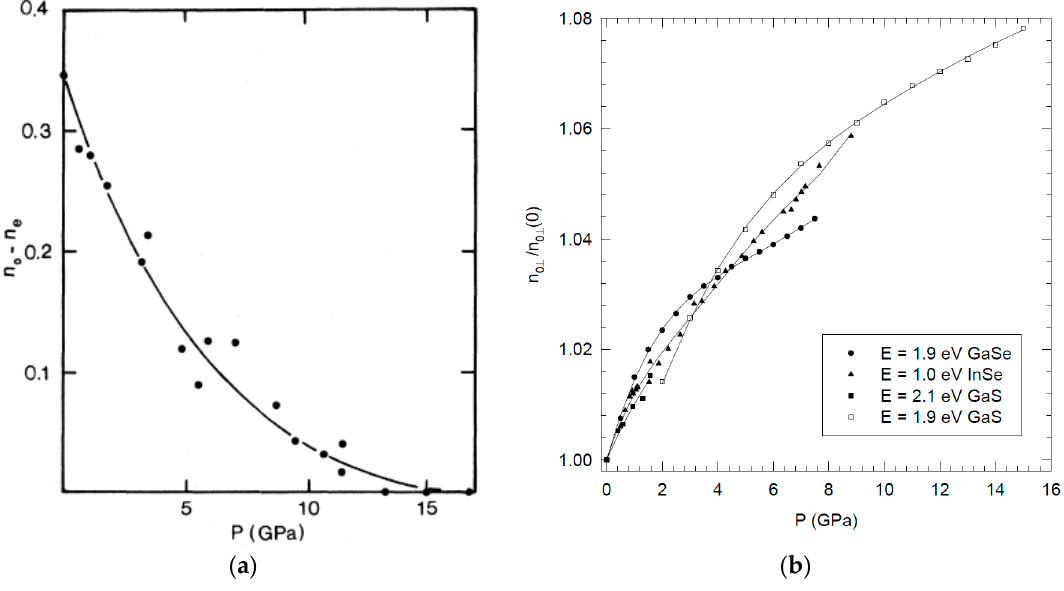
Figure 18. ( a ) Pressure dependence of the birefringence in β -GaS [79]. ( b ) Relative change of the refractive index (cid:1866) (cid:2884) as a function of pressure for β -GaS, ε -GaSe, and γ -InSe [80].